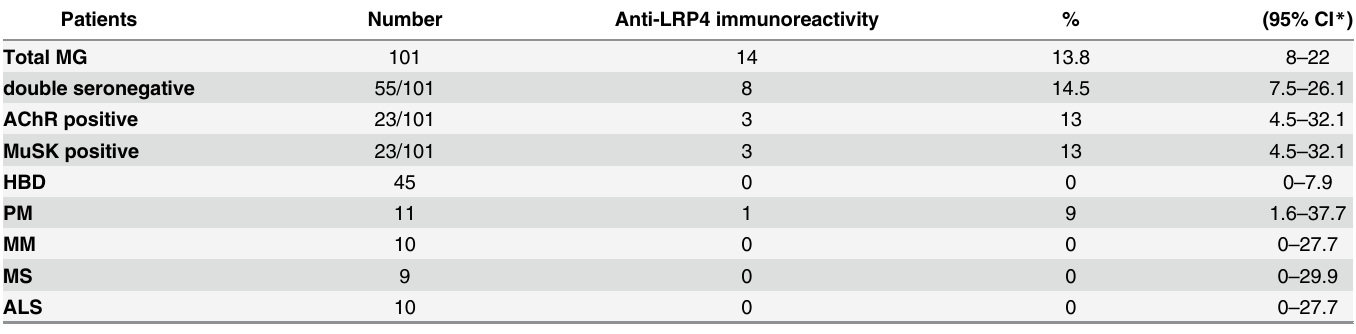
Table 1. Anti-LRP4 immunoreactivity in 101 Italian myasthenic patients (MG) and controls.